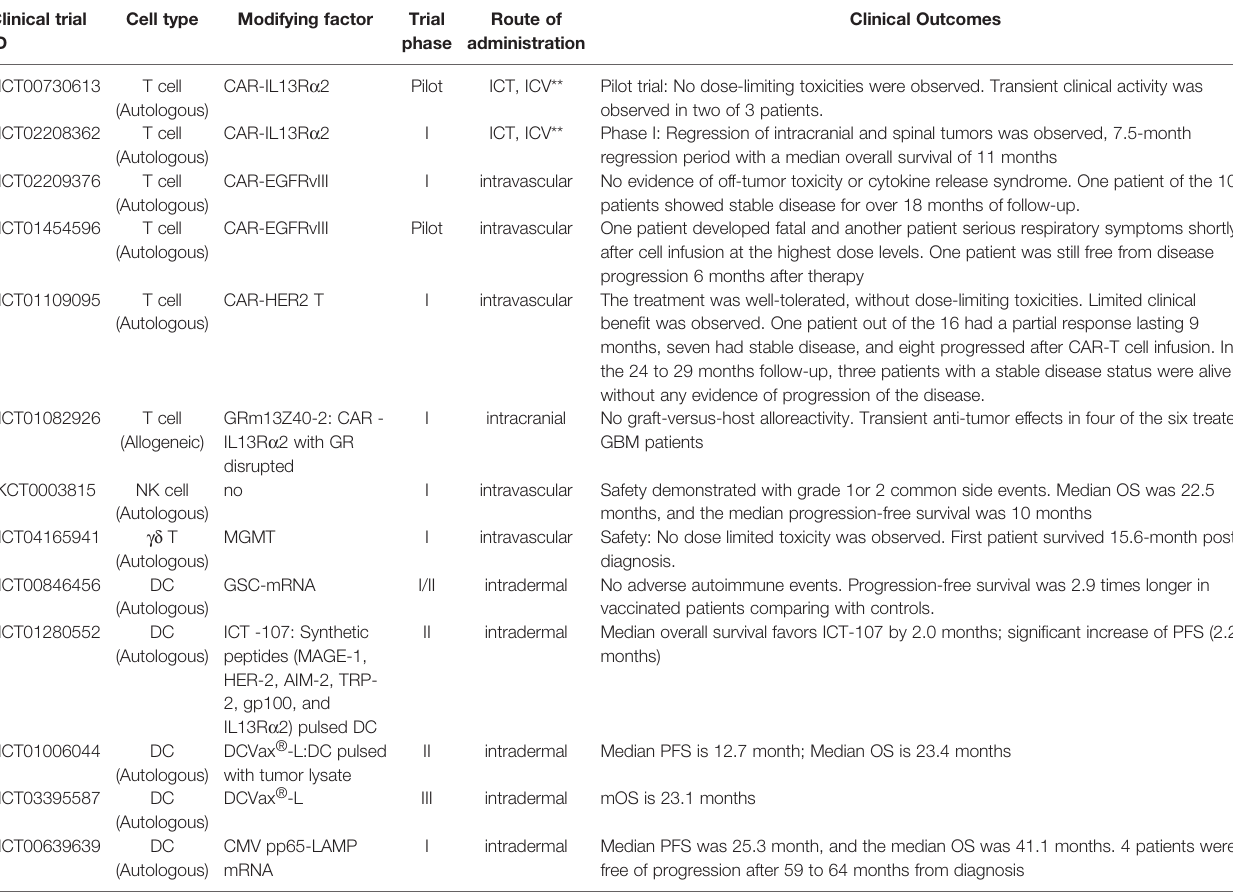
TABLE 1 | Clinical trials of immune cell-based glioblastoma therapy with clinical outcomes. Clinical trial